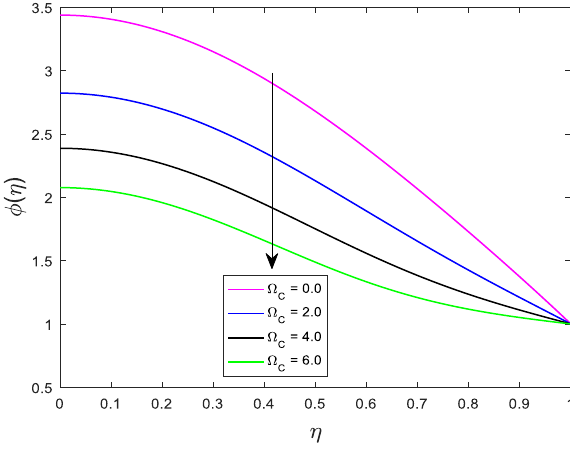
Figure 15: Effect of Ω T on ϕ ( η ) for fixed S = N b = Ec = 0.5, β = Ha = N t = Ω C = Kr = 0.1, Pr = 1.5 and Sc = 0.7